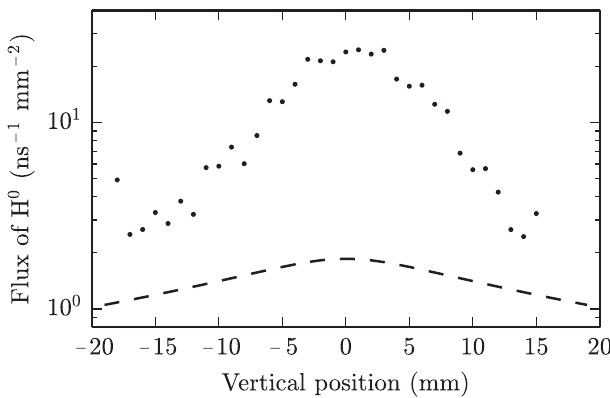
FIG. 3. Flux of H 0 arriving at the detection plane from laser stripping in the center of the H − beam — in average while laser pulse duration — (dots); H 0 flux from the residual gas background — permanently while macro-pulse — (dashed